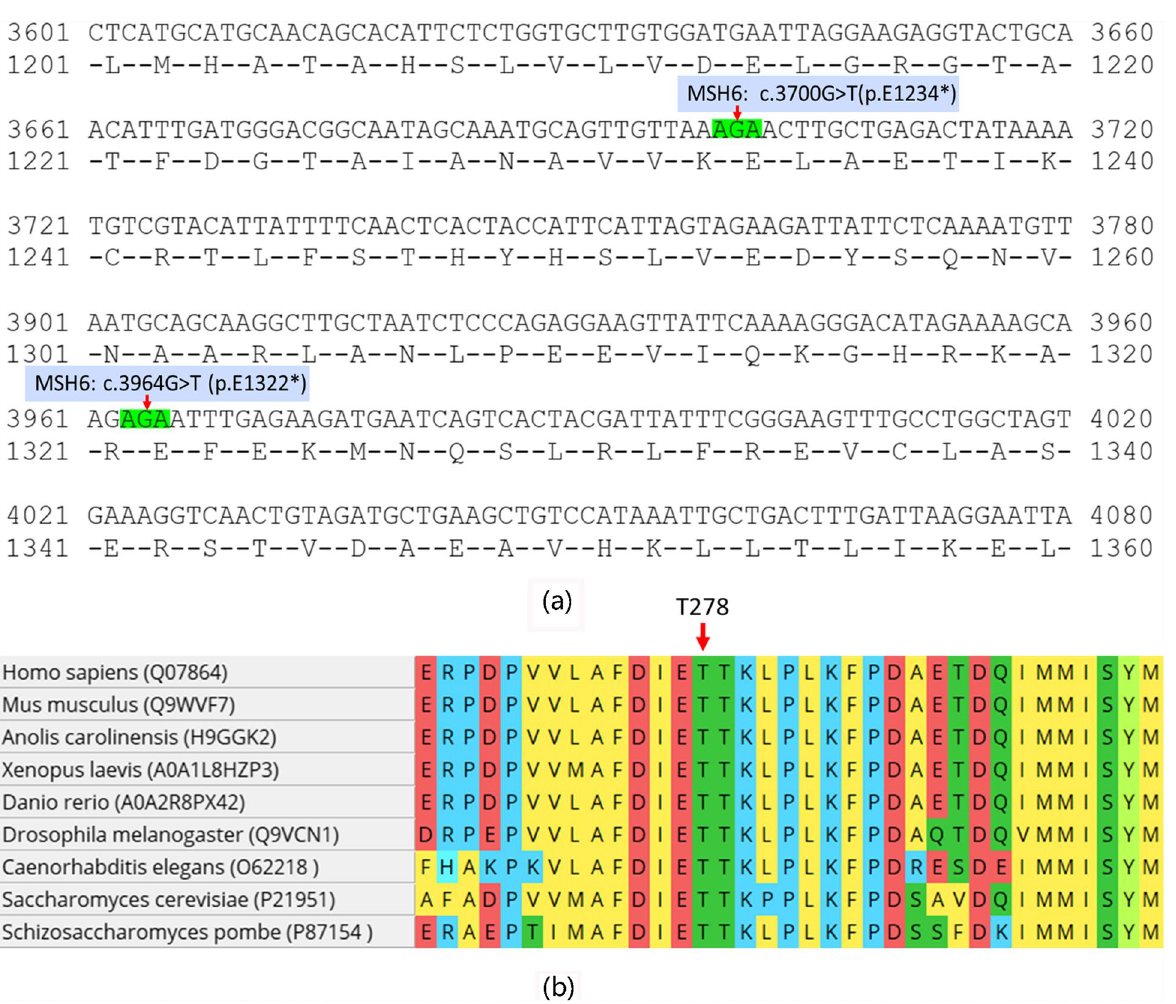
Fig. 2 a secondary nonsense mutation in MSH6 in AGA (3’ to 5’) context. b T278K line in a highly conserved position in the exonuclease domain of POLE.